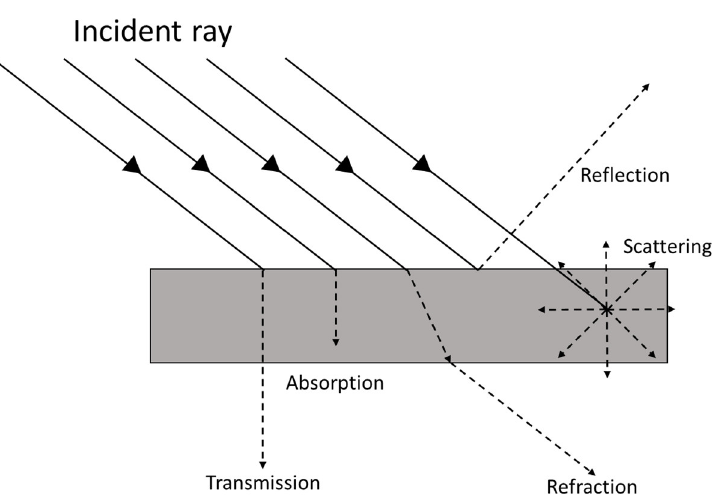
Figure 16. Light phenomenon when the material is exposed to electromagnetic radiation (light). Transparent samples (glass) refract the incident ray; almost all the material reflects light but at different angles of reflection, i.e., a smooth surface reflects the light at an identical angle; light transmits through translucent and transparent materials (glass–ceramics or ceramics-based materials); high-light-absorption materials absorb light and may scatter as a form of heat (CNTs-added ceramics).